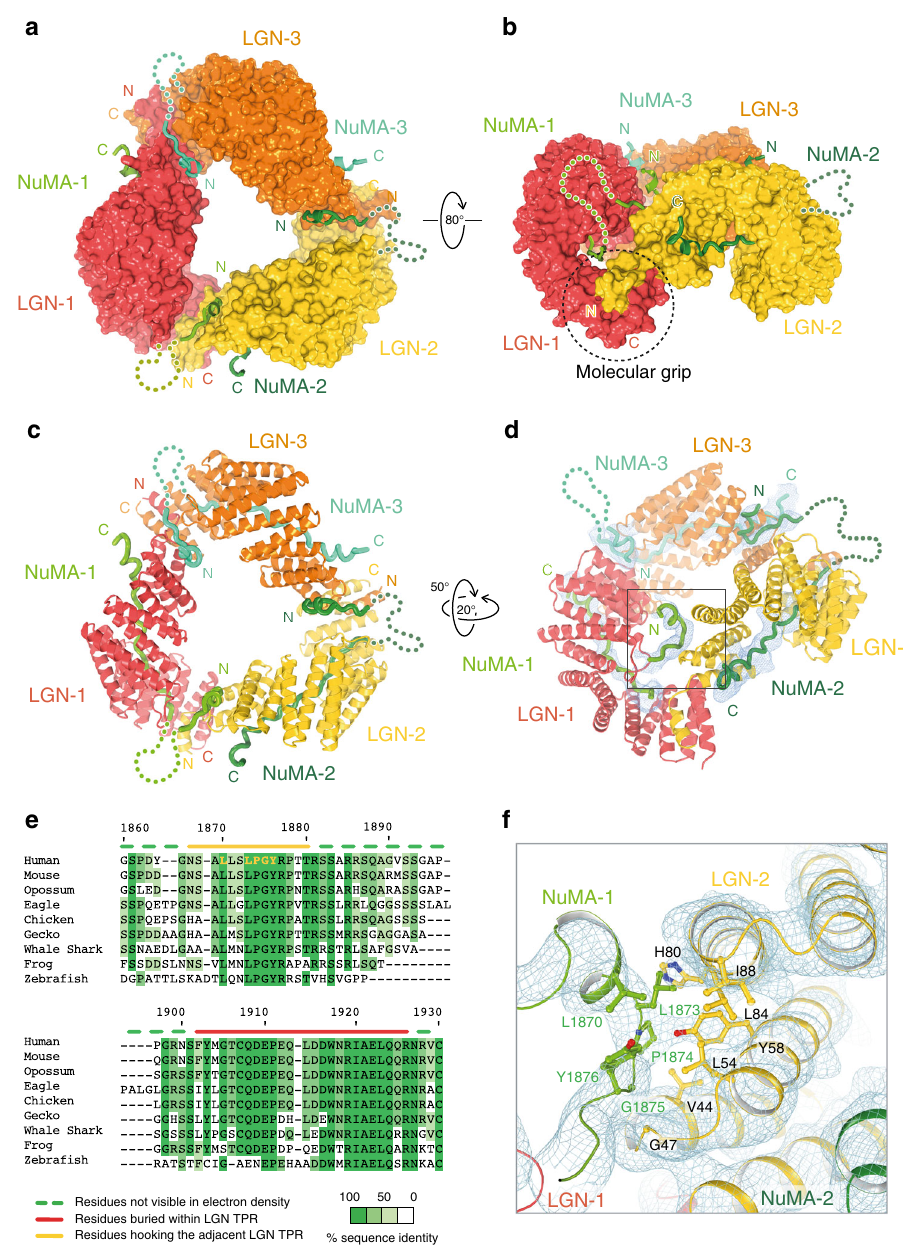
Fig. 2 Structure of the hetero-hexameric LGN:NuMA complex. a – b LGN:NuMA hetero-hexamer with LGN molecules depicted with surface representations in red, orange and yellow, and NuMA molecules as coils in different shades of green. Unstructured regions are represented with dotted lines. Panel b highlights the ‘ molecular grip ’ between the N-terminal LGN-2 capping helix (yellow N-term) with the LGN-1 TPR8 (red C-term). c – d Cartoon representations of the hetero-hexameric complex. Panel c is in the same orientation of a, whilst panel d highlights the hooking mechanism of NuMA LGNBD N-terminal on the adjacent LGN TPR . An electron density map (Fo-Fc omit map calculated omitting NuMA LGNBD chains) is displayed at 2.2- σ contour level. e Excerpt of NuMA sequence alignment encompassing the crystallized fragment, colored by percentage of sequence identity (details in Methods section). Residues built in the crystal structure are indicated with overlying yellow and red lines, those for which there is no electron density with overlying green dotted line. Residues of the NuMA hooking peptide contacting LGN are depicted in bold yellow. f Enlarged view of the region highlighted in the box of panel d , with ball-and-stick representation of the residues involved in the hooking interface between NuMA-1 and LGN-2. A 2Fo-Fc electron density map, contoured at 1- σ level, is